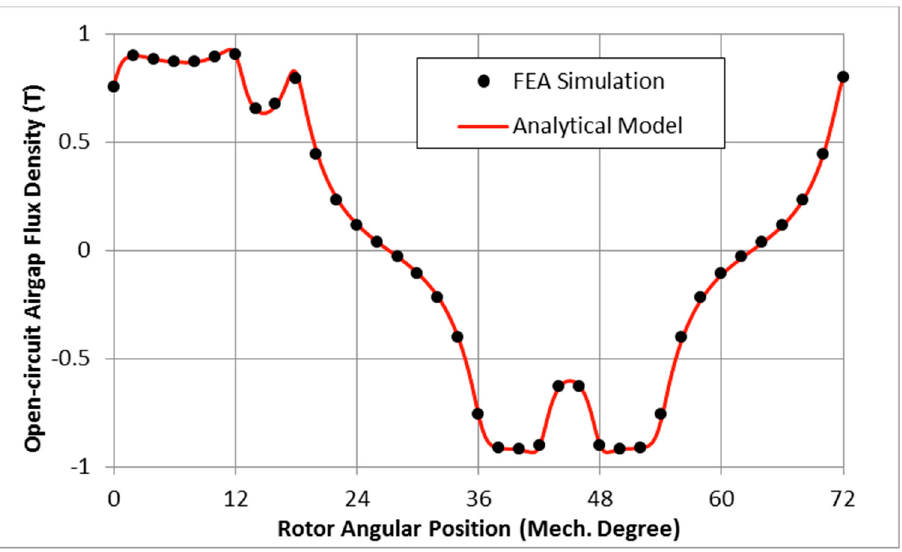
Figure 6. Comparison of FEA and Analytically Predicted Air-gap Flux Density, R mp =